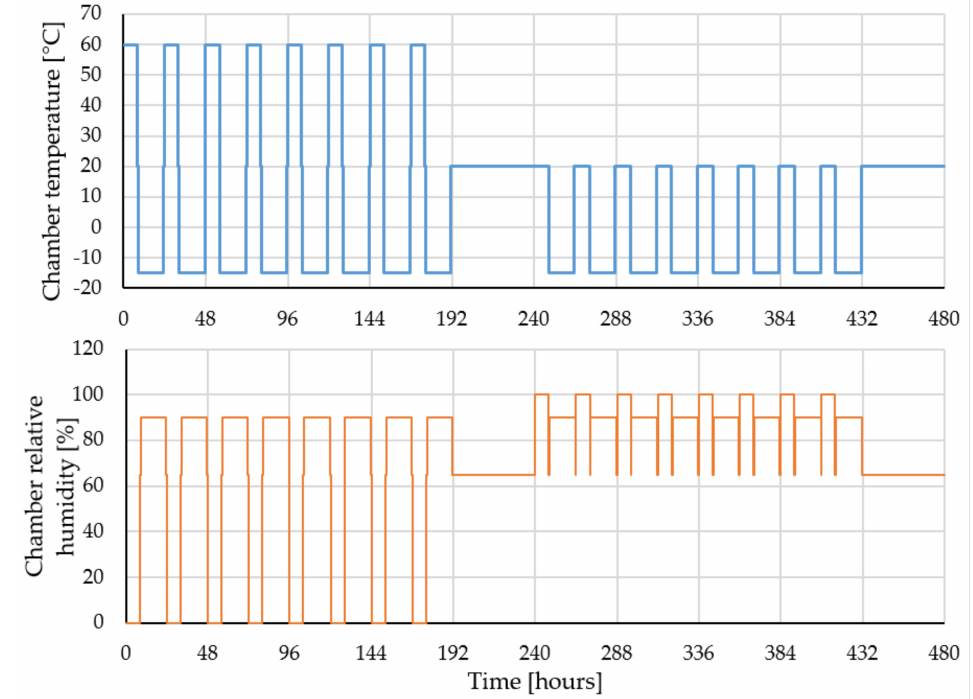
Figure 15. Total accelerated hygrothermal aging